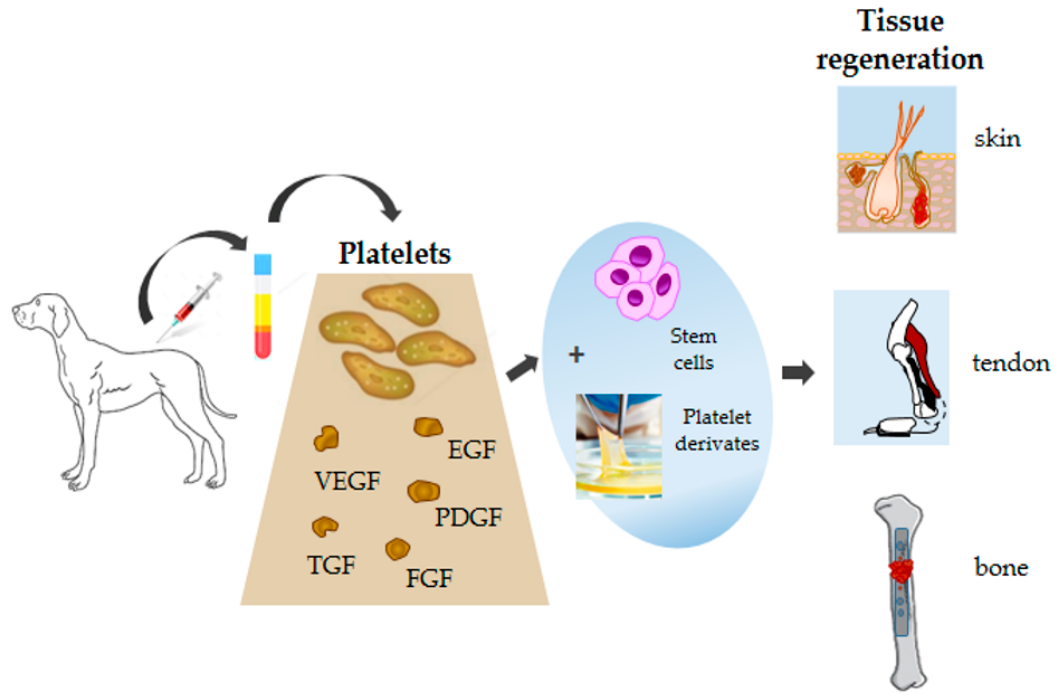
Figure 3. Schematic diagram showing canine platelets, their components, and potential applications in tissue regeneration.